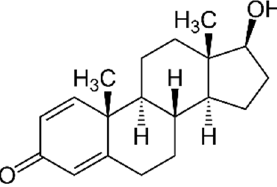
Figure 5. Chemical structure of boldenone. Formula: C 19 H 26 O 2.